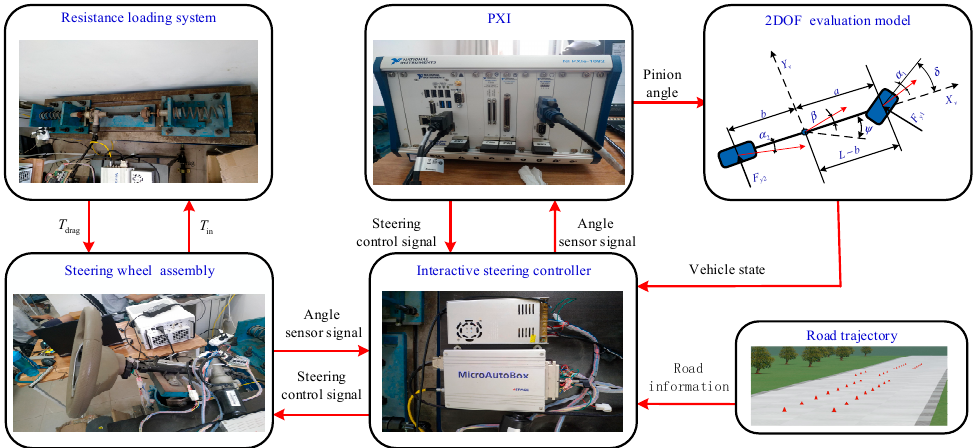
Figure 5. Active steering hardware in the loop test bench.